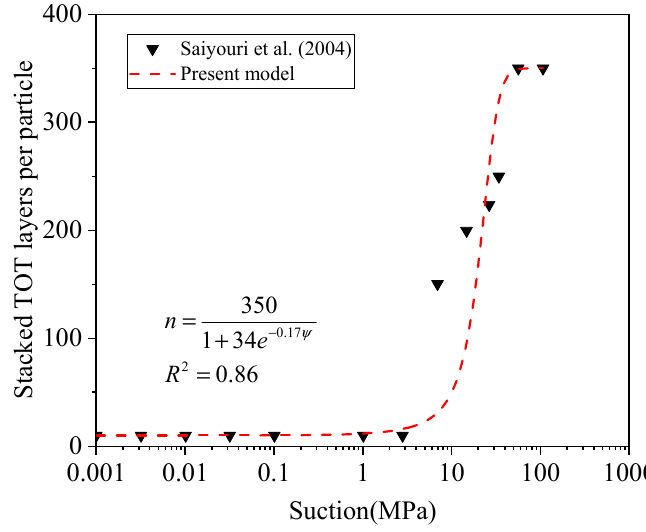
Figure 4. Relationship between stacked TOT layers per bentonite particle and suction. Consequently, the external specific area can be illustrated, A tot = A ext = n c To derive macro porosity (effective porosity), the data from Table 3 are substituted into Equation (26), and the results are shown in Figure 5 (the red line). To evaluate its accuracy, this work compares with the theoretical method of micro porosity proposed by Sedighi and Thomas [52] as Equation (41),